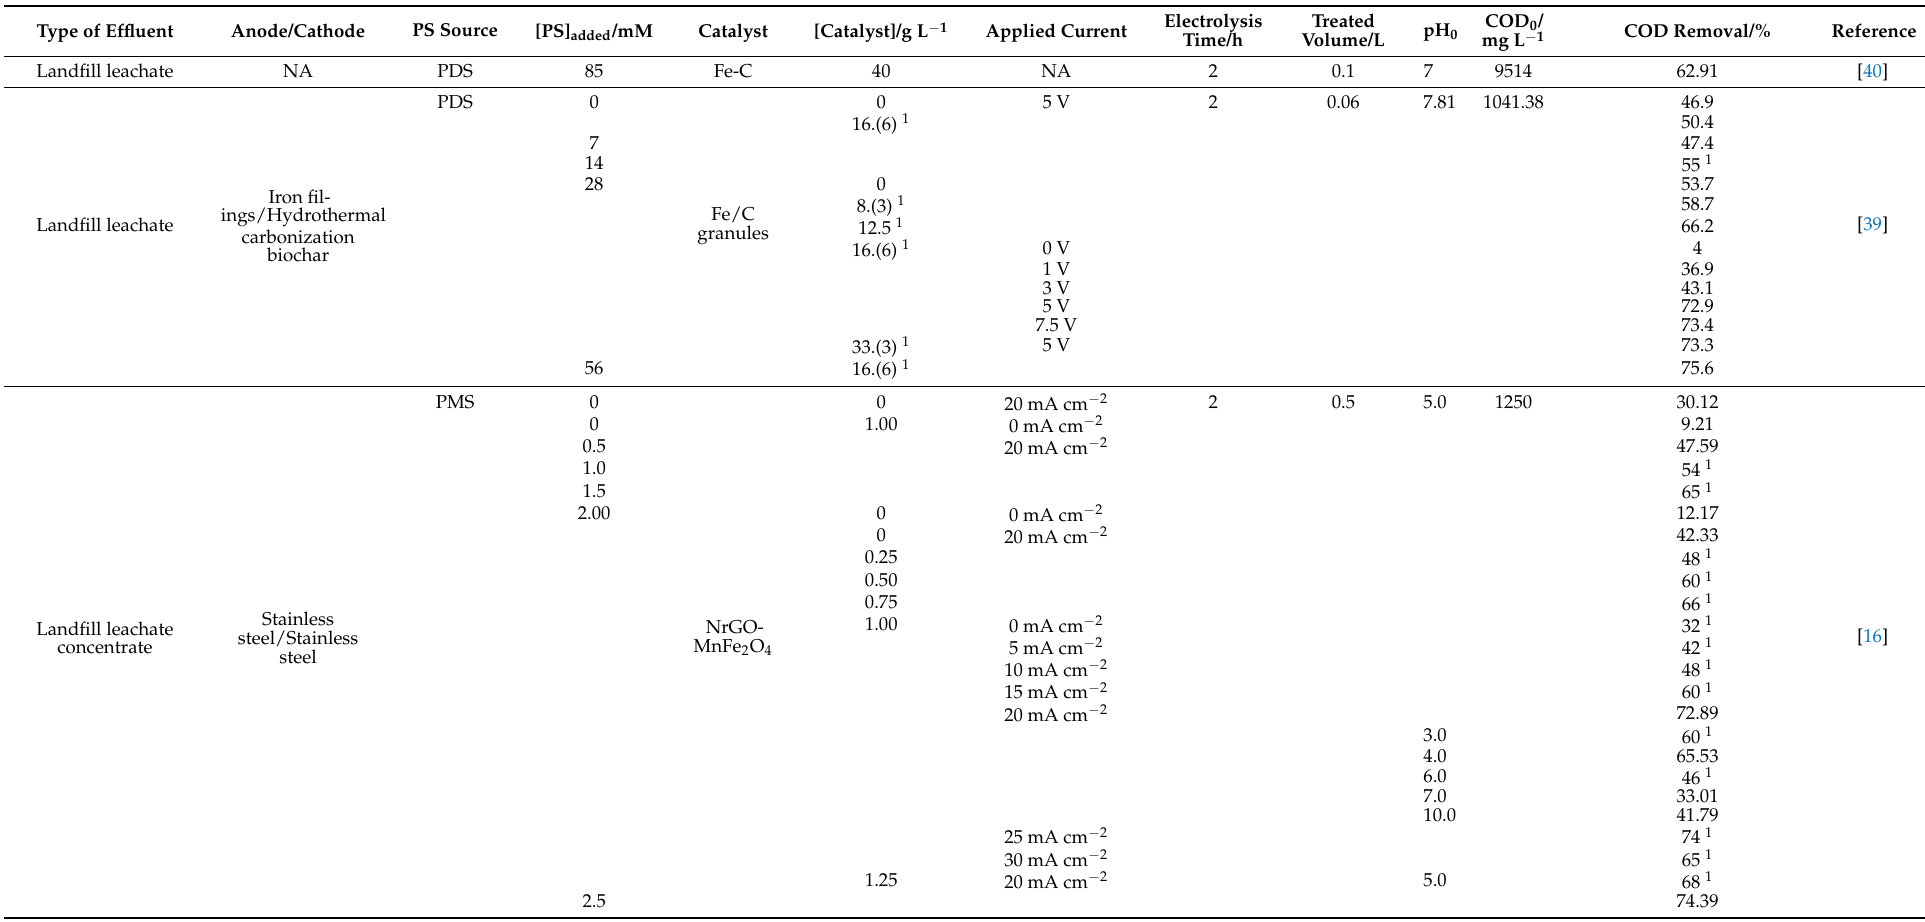
Table 4. Summary of research results previously reported for persulfate electro-activation using metal-based catalysts in the treatment of complex